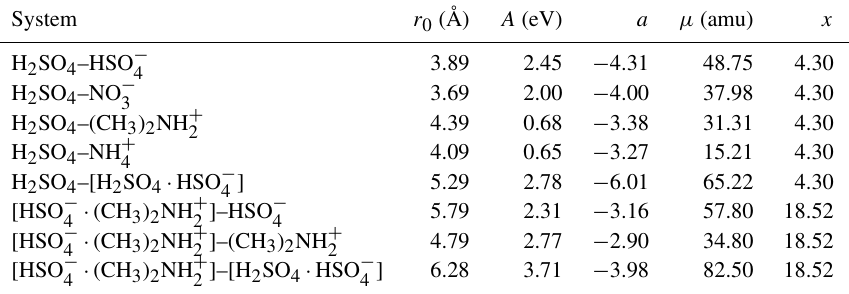
Table 1. The location of the potential minimum r 0 , the interaction coefficient A , and the interaction exponent a , obtained by fitting Eq. (1) to the potential of mean force, and the reduced mass µ and the x parameter in the Su and Chesnavich (1982) parametrization, for each studied ion–dipole